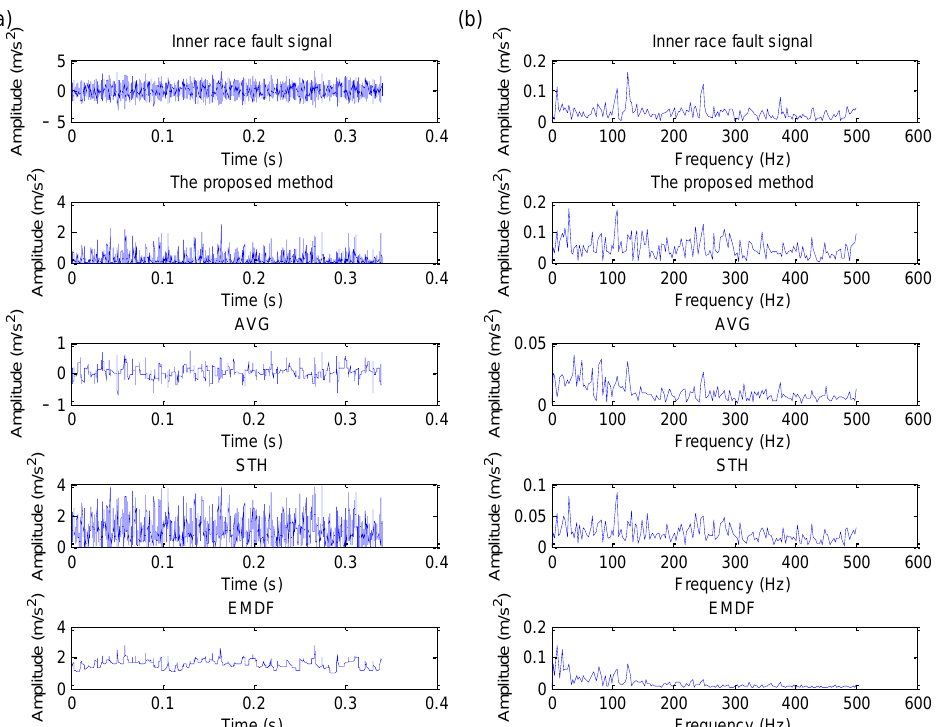
Figure 20. Analysis results obtained by different methods for dataset 3001 in case 2: ( a ) Time domain waveform; ( b ) its corresponding envelope spectrum.